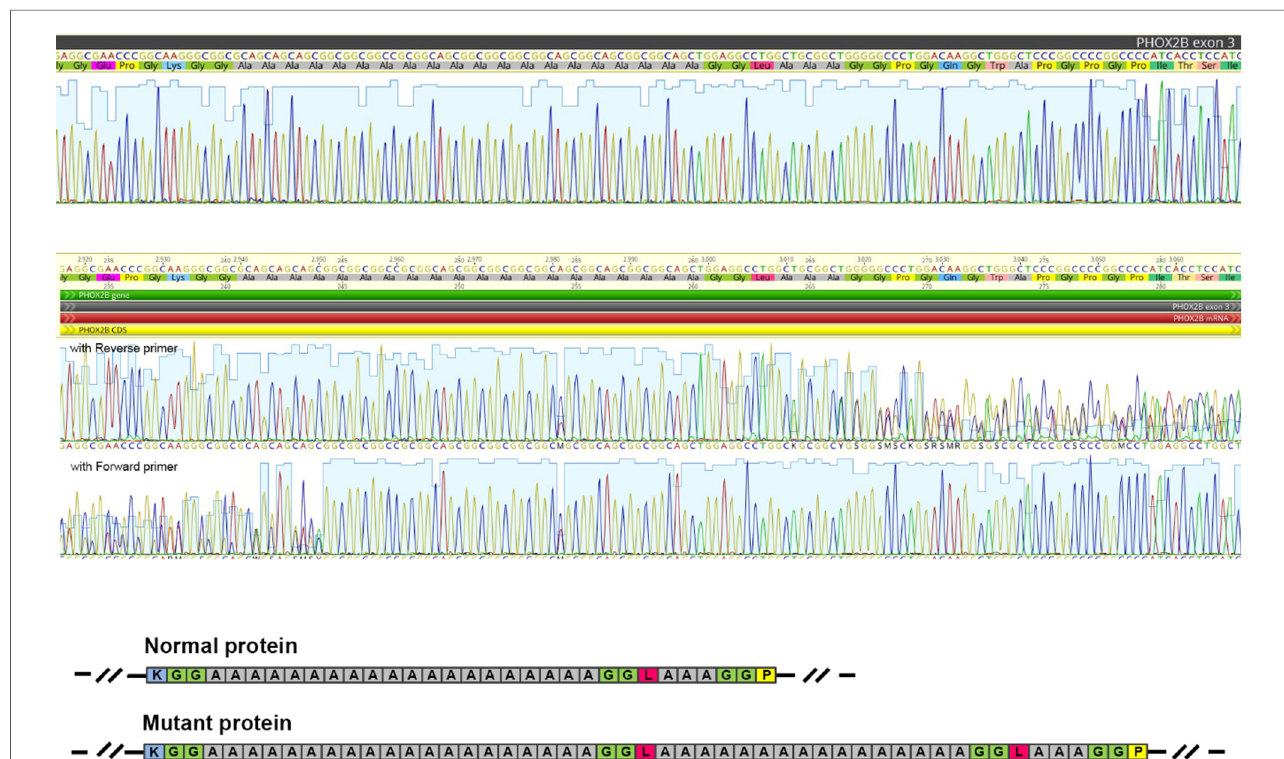
FIGURE 1 The PHOX2B genetic variant (p.Ala248_Ala266dup) was revealed by Sanger sequencing. The fi gure shows a fragment of Sanger sequencing chromatogram corresponding to the polyalanine repeat and fl aking regions in a control ( “ reference ” ) sample ( A ) and in the reported patient ( B ). ( C ) The scheme illustrating the impact of the duplication on the amino acid sequence in the mutant protein. Colored boxes represent amino acid residues (blue — lysin, green — glycine, grey — alanine, magenta — leucine, and yellow —